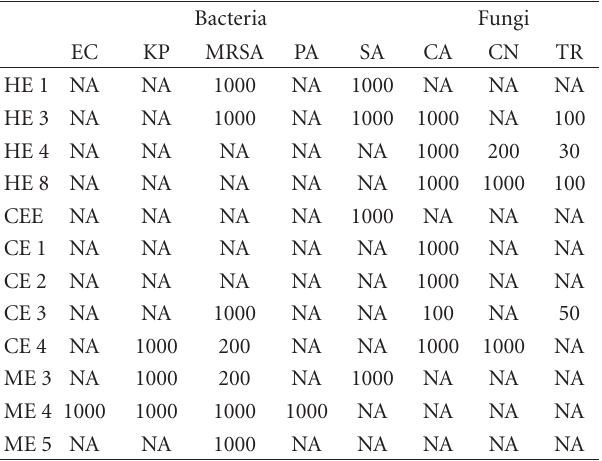
Table 1: Antimicrobial activity of extracts and fractions of Laennecia confusa expressed as MIC ( µ g/mL). Bacteria Fungi